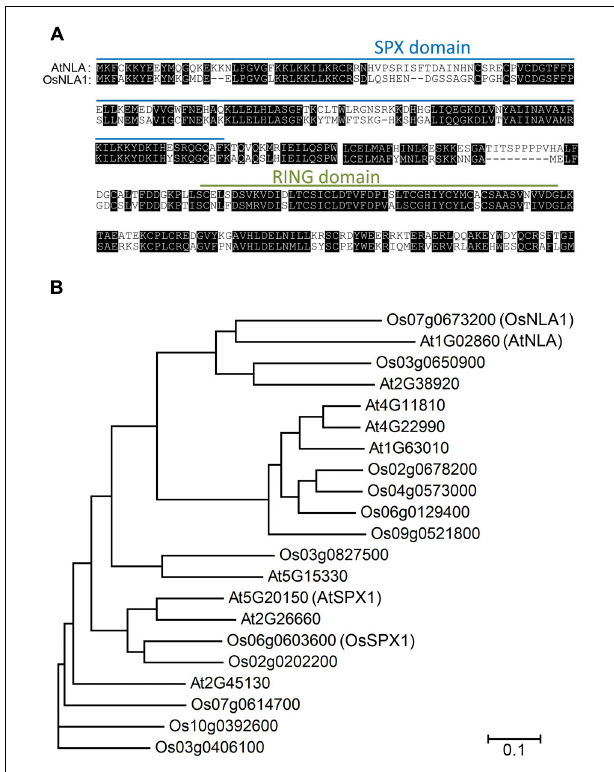
FIGURE 1 | Comparison of AtNLA and OsNLA1 protein sequences and phylogenetic tree analysis. (A) The amino acid sequence of OsNLA1 has 59.7% sequence identity to AtNLA. OsNLA1 has an N-terminal SPX domain and a C-terminal RING domain. (B) Phylogenetic analysis with other related SPX proteins in Arabidopsis and rice.